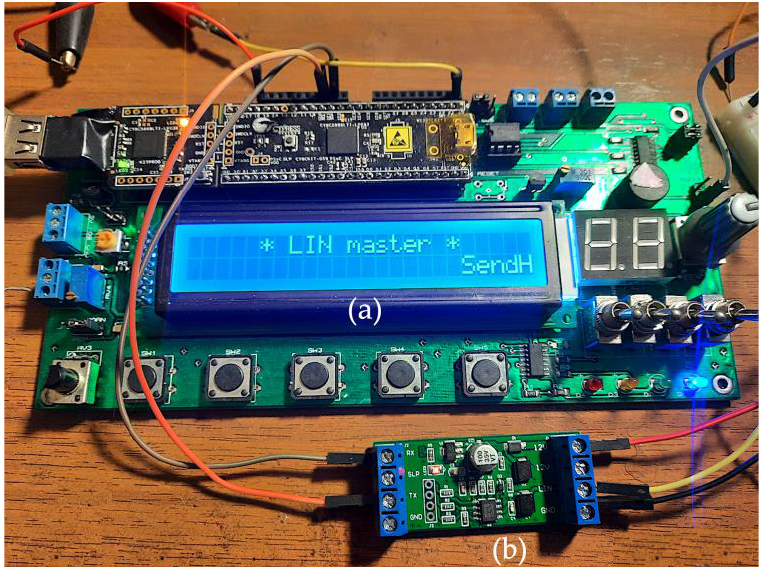
Figure 10. Prototype LIN node composed of a ( a ) development board and ( b ) LIN transceiver.